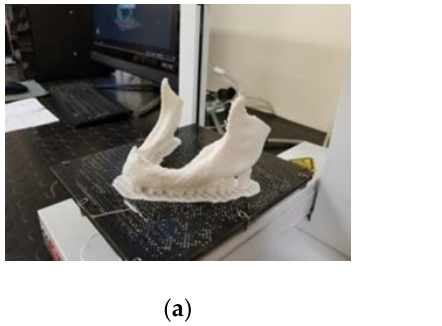
. Figure 3. The process of grouping data for the Precimid 1170 material. Then, a group of pixels representing the anatomical structure of the mandible was selected and subjected to geometric reconstruction using the active contour algorithm. This algorithm adjusts the contour to the outline of the anatomical structure determined in the segmentation process, allowing us in the end to fully reconstruct the geometry of the mandible.